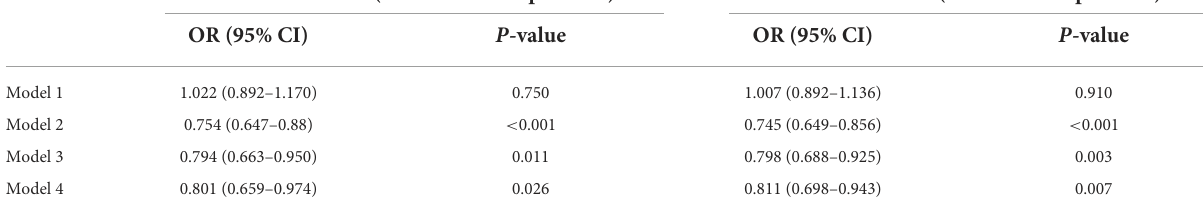
TABLE 4 ORs (95%CIs) of the association between serum cadmium levels and diabetes in the low cadmium exposure group. ORs (95%CIs) in the low cadmium exposure group Variable Serum cadmium (Before the interpolation) Serum cadmium (after the interpolation)